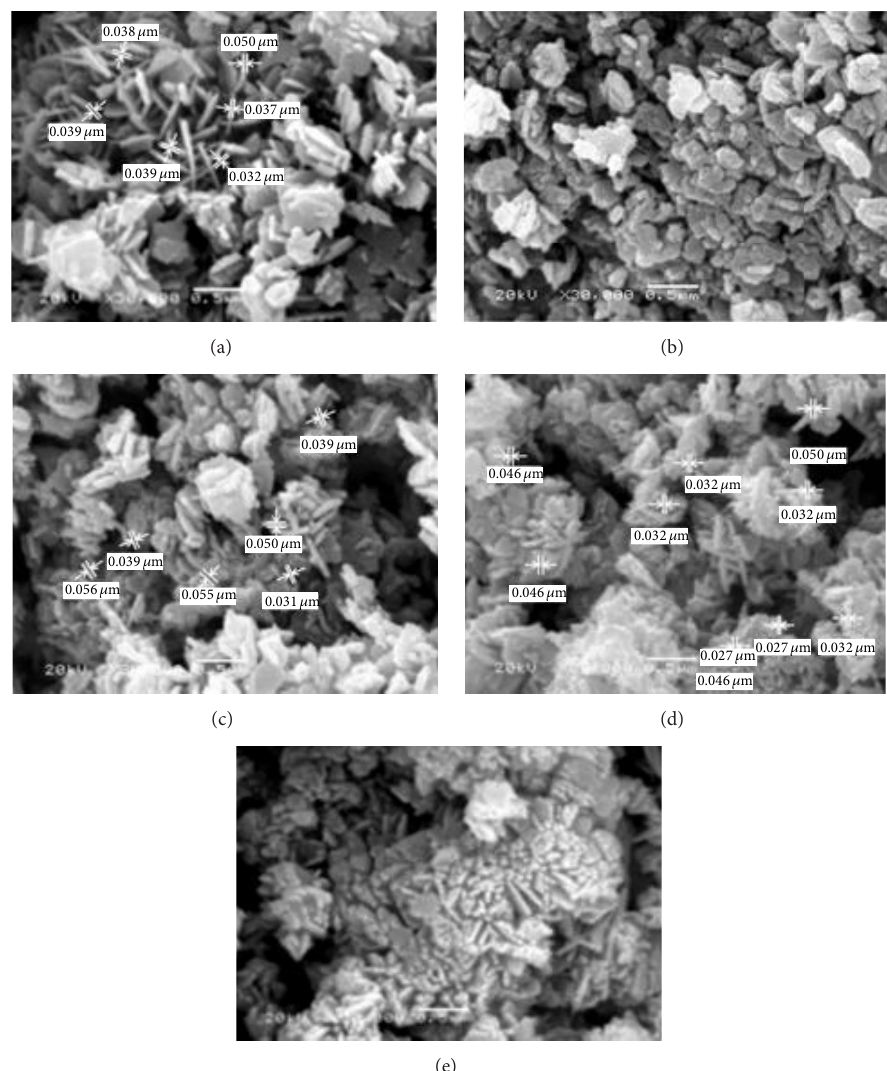
Figure 14: SEM micrographs of ZnO prepared using hydrothermal technique with different reaction times: (a) 3 h, (b) 6 h, (c) 12 h, (d) 24 h, and (e) 48h.